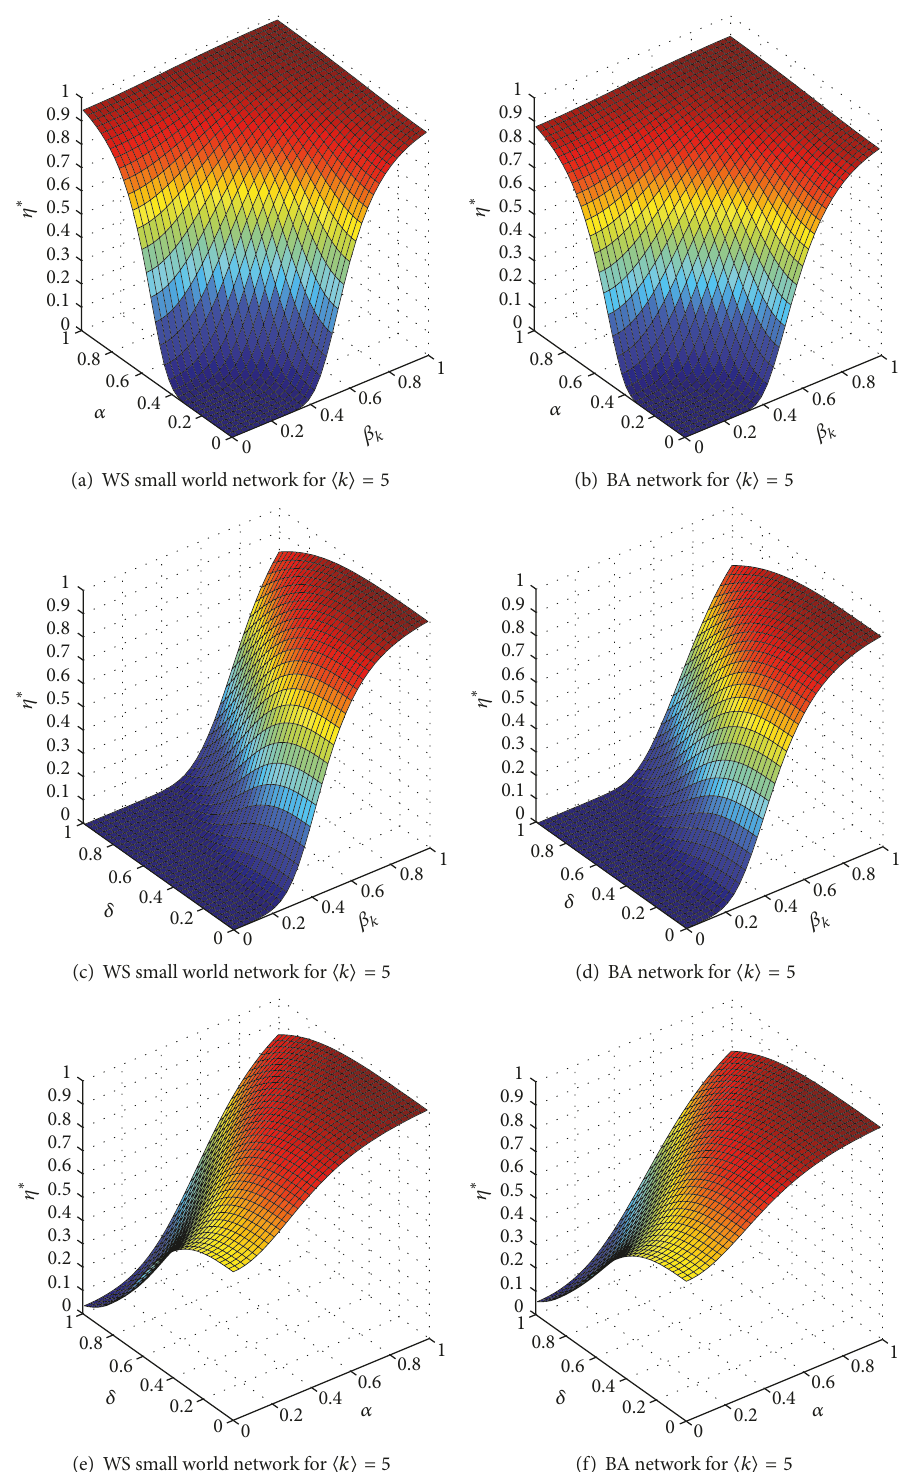
Figure 2: The influencing mechanism of the interaction among the effect degree 𝛼 of market noises, the risk preference level 𝛽 𝑘 of investors, and the supervision strength 𝛿 of financial market regulators on the equilibrium point 𝜂 ∗ of the credit risk contagion system under the different network structure. (a) and (b) for 𝛿 = 0.4 , 𝜃 = 0.5 , 𝜂 = 0.6 , 𝜇 = 0.3 , 𝜌 = 0.2 , 𝜆 = 0.3 , 𝑐 𝑘 = 0.1 ; (c) and (d) for 𝛼 = 0.3 , 𝜃 = 0.5 , 𝜂 = 0.6 , 𝜇 = 0.3 , 𝜌 = 0.2 , 𝜆 = 0.3 , 𝑐 = 0.1 ; (e) and (f) for 𝛽 = 0.6 , 𝜃 = 0.5 , 𝜂 = 0.6 , 𝜇 = 0.3 , 𝜌 = 0.2 , 𝜆 = 0.3 , 𝑐 = 0.1 𝑘 𝑘 𝑘